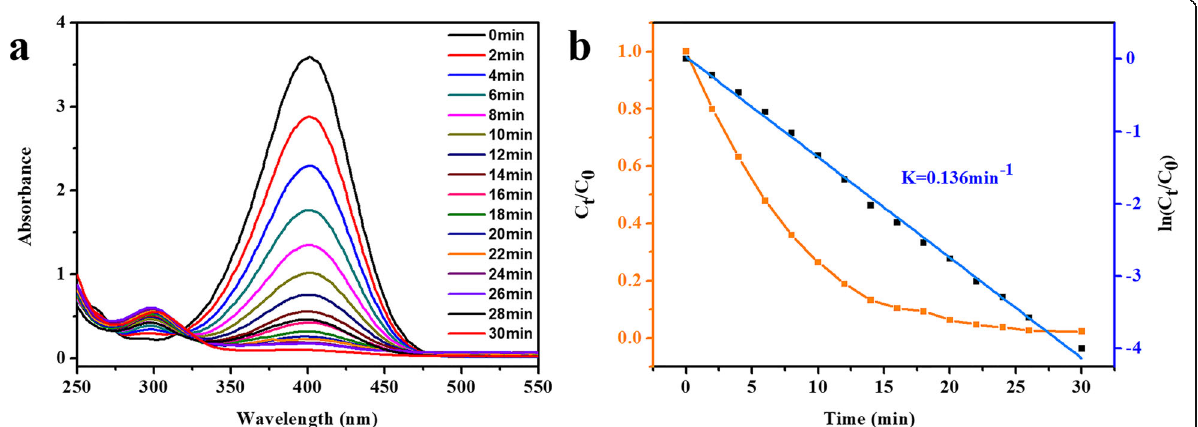
Fig. 9 Catalytic performance of GA@AgNPs-LA-CP for the catalysis of 4-NP to 4-AP. Time-dependent UV-vis spectral changes a and the reaction kinetics curve